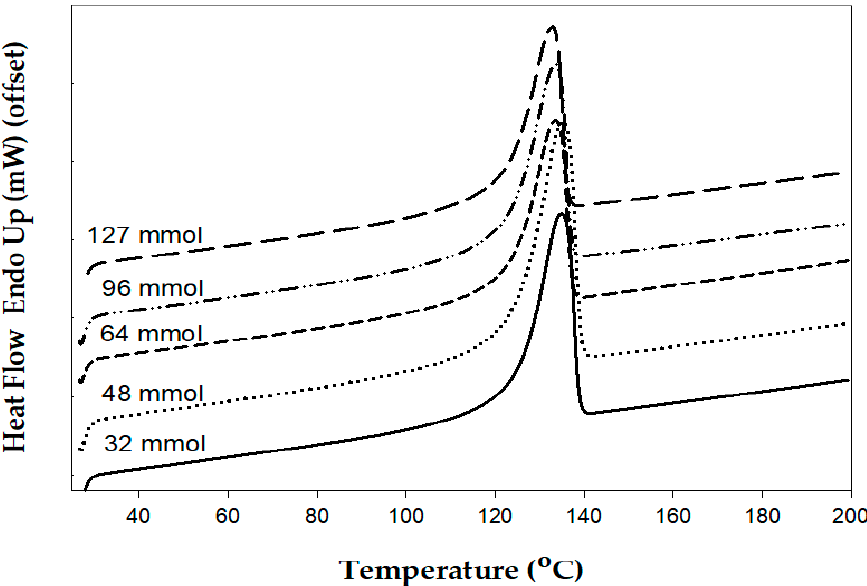
Figure 7. DSC second heating curve of the copolymer with various 1-octene concentrations.